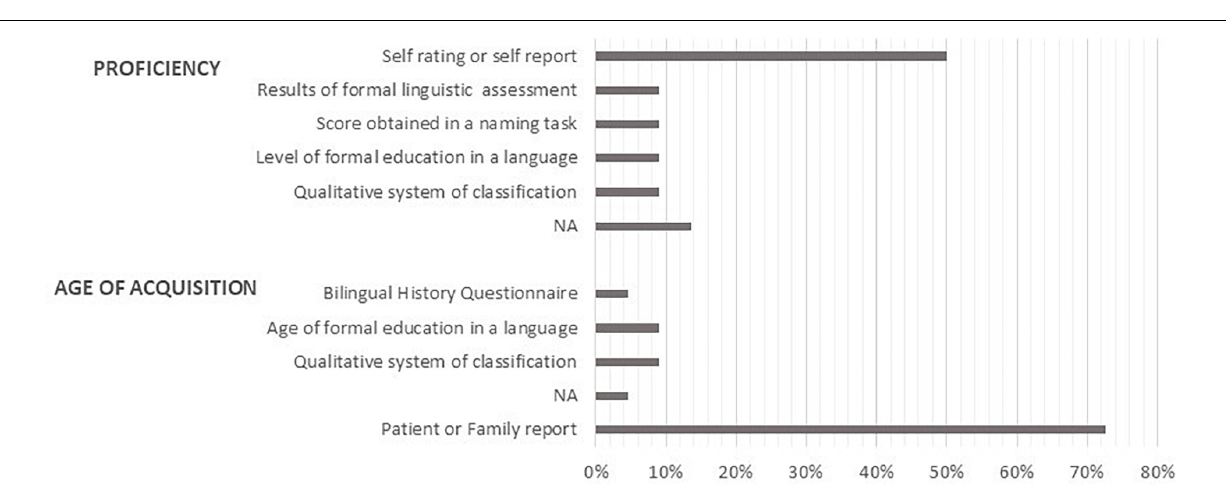
FIGURE 3 | Methods used to assess proficiency and age of